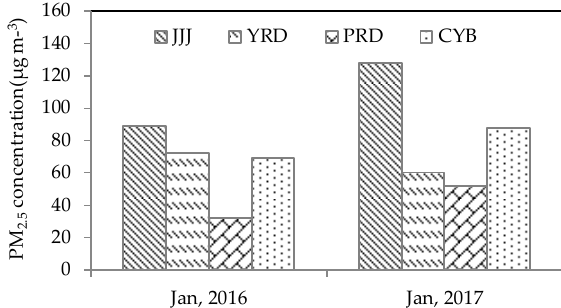
Figure 4. Distribution of PM 2.5 concentration in major regions.